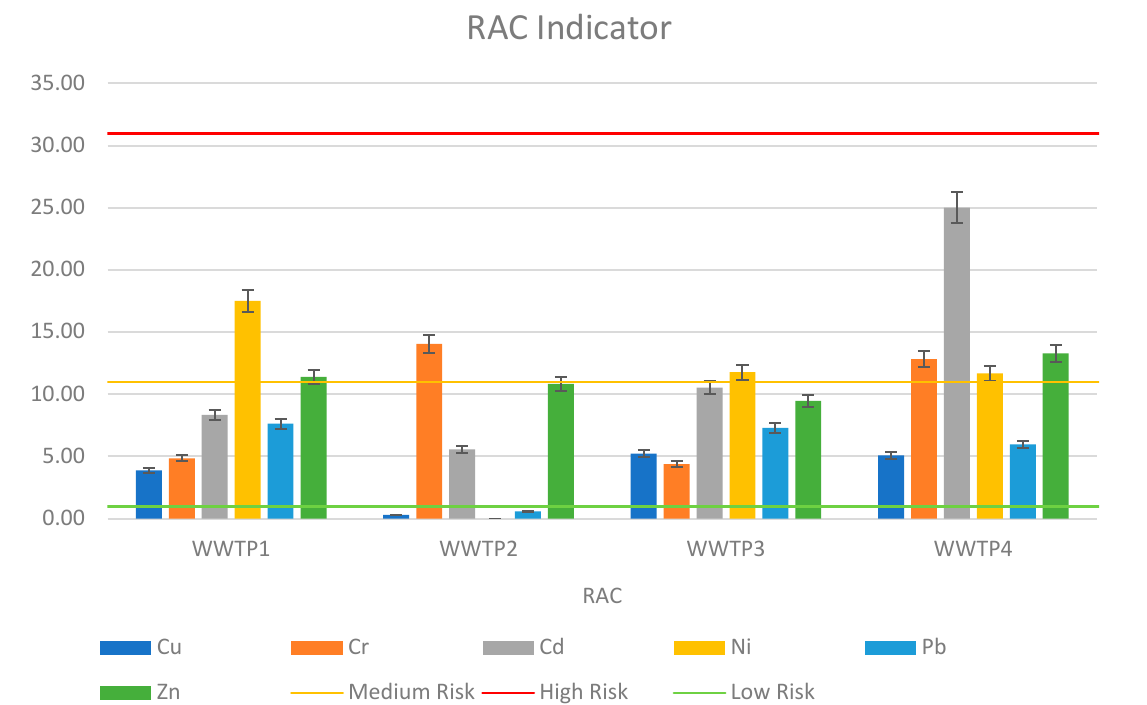
Figure 3. Risk assessment code (RAC) of HMs in sewage sludge.